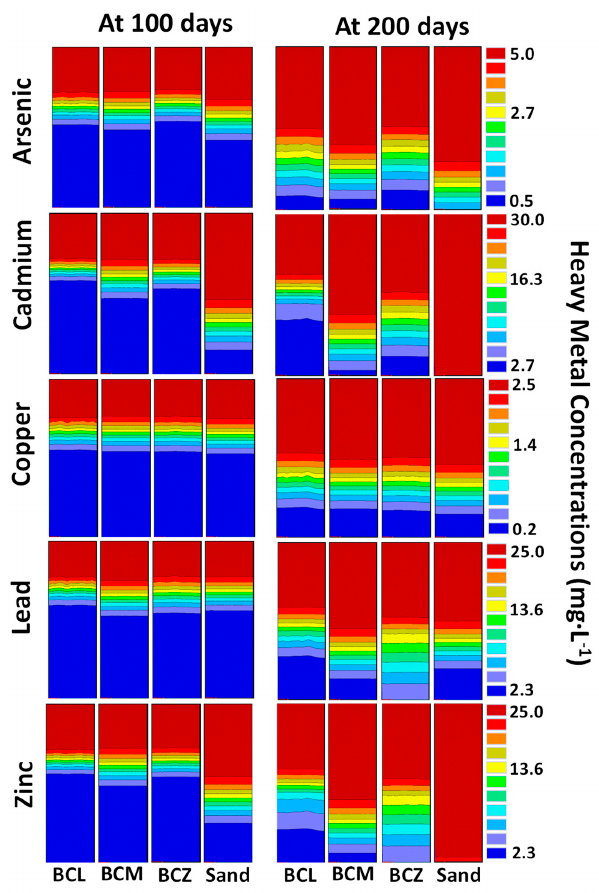
Figure 7. Transport of metals through columns at 100 days and 200 days via HYDRUS 2D modeling.